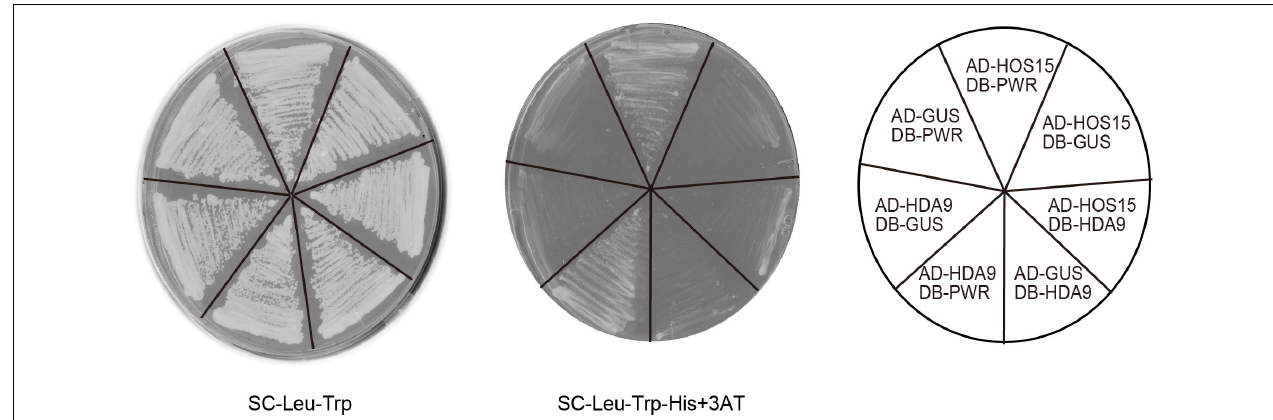
FIGURE 6 | Yeast two-hybrid assay using HOS15, HDA9, and PWR. Yeast cells grown on synthetic complete (SC) medium lacking leucine (Leu) and tryptophan (Trp) are shown in the left panel. Yeast cells grown on SC lacking Leu, Trp, and histidine (His), but containing 20 mM 3-amino-1,2-4-triazole (3AT) are shown in the middle panel. Combinations of vectors used are indicated in the right panel. GUS was used as a negative control. AD and DB indicate the activation domain and DNA-binding domain of GAL4, respectively.